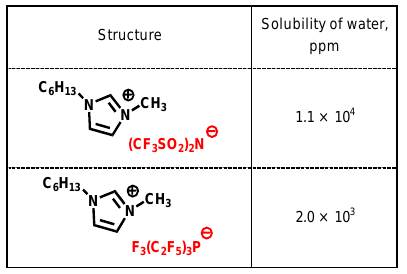
Table 3. Solubility of water in HMIM derived ionic liquid.